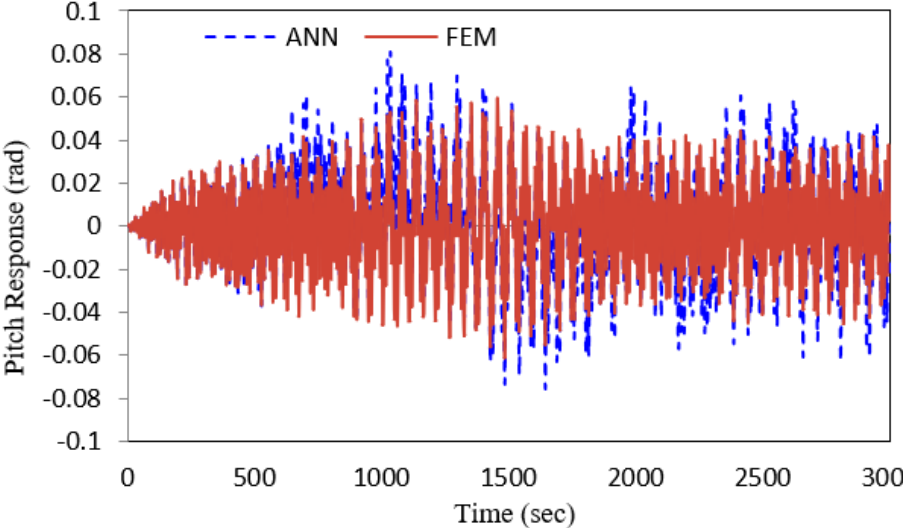
Figure 11. Pitch response time history predicted for wave height of 12.65 m and wave period of 11.39 s.